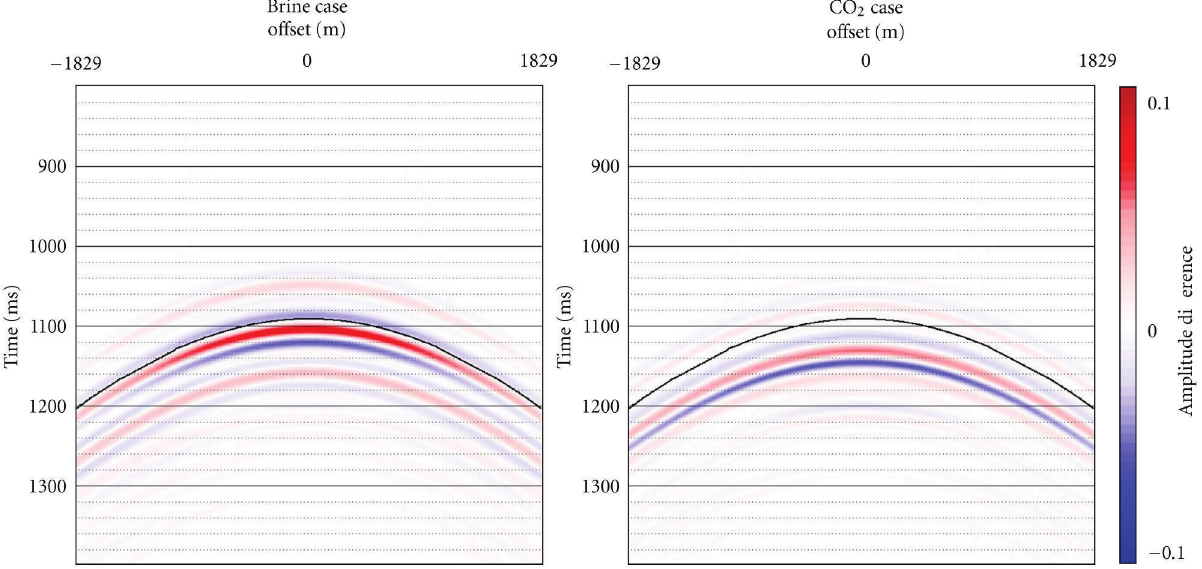
Figure 19: Comparison of the P-wave amplitude di ff erence for the brine- and CO 2 -saturated cases with a pore pressure increase from 6.89MPa to 29.65 MPa. The Morrow A sandstone top is indicated by the black